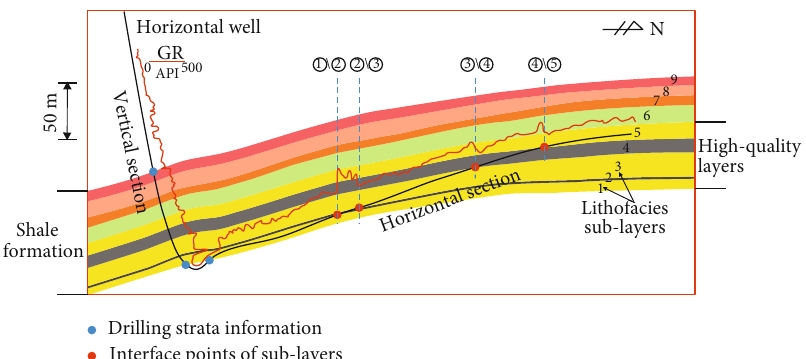
Figure 5: Calibration of lithofacies sublayers on a horizontal well for providing interfacial points of sublayers for the model and clearing the drilling trajectory passing through the sublayers in the